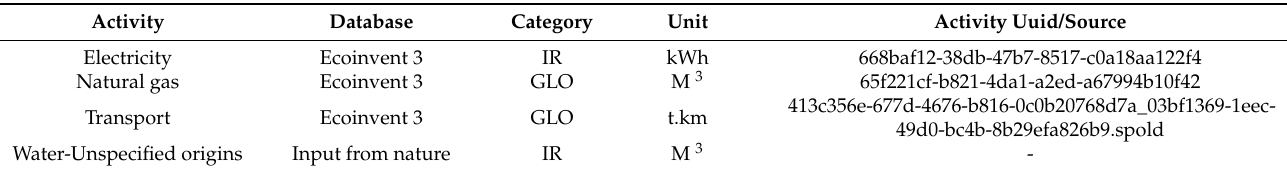
Table 1. Datasets applied for calculation of emissions from off-site operations.